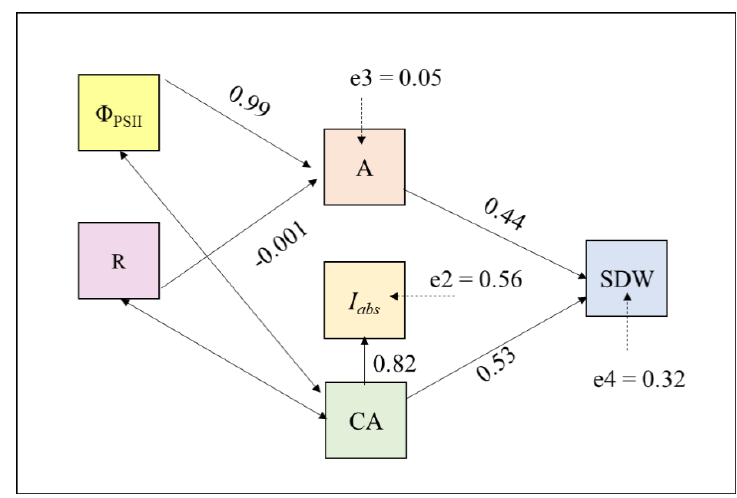
Figure 4. Path analyses of physiological measurements associated with shoot dry weight (SDW). Other variables include leaf photosynthesis (A), canopy area (CA), light absorption ( I abs ), reflectance index (R) and quantum efficiency in light (Φ PSII ). Beta (or linear coefficient) and error values are shown for different effects. The model used terms that showed statistical significance ( p ≤ 0.05).